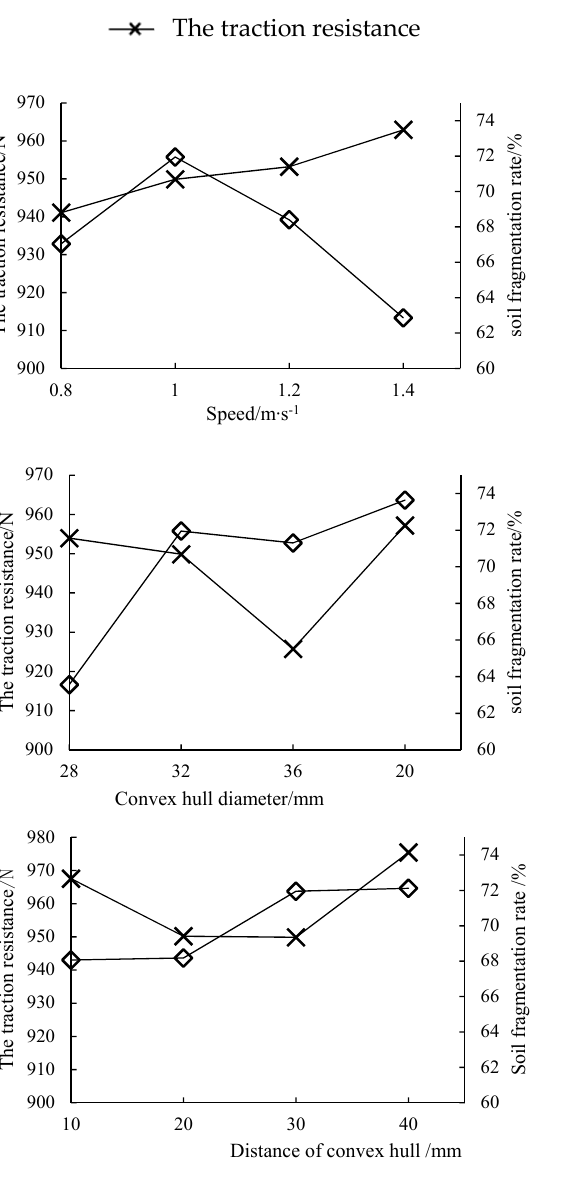
Figure 5. The effect of speed and surface texture structure parameters on the traction resistance and soil fragmentation rate.